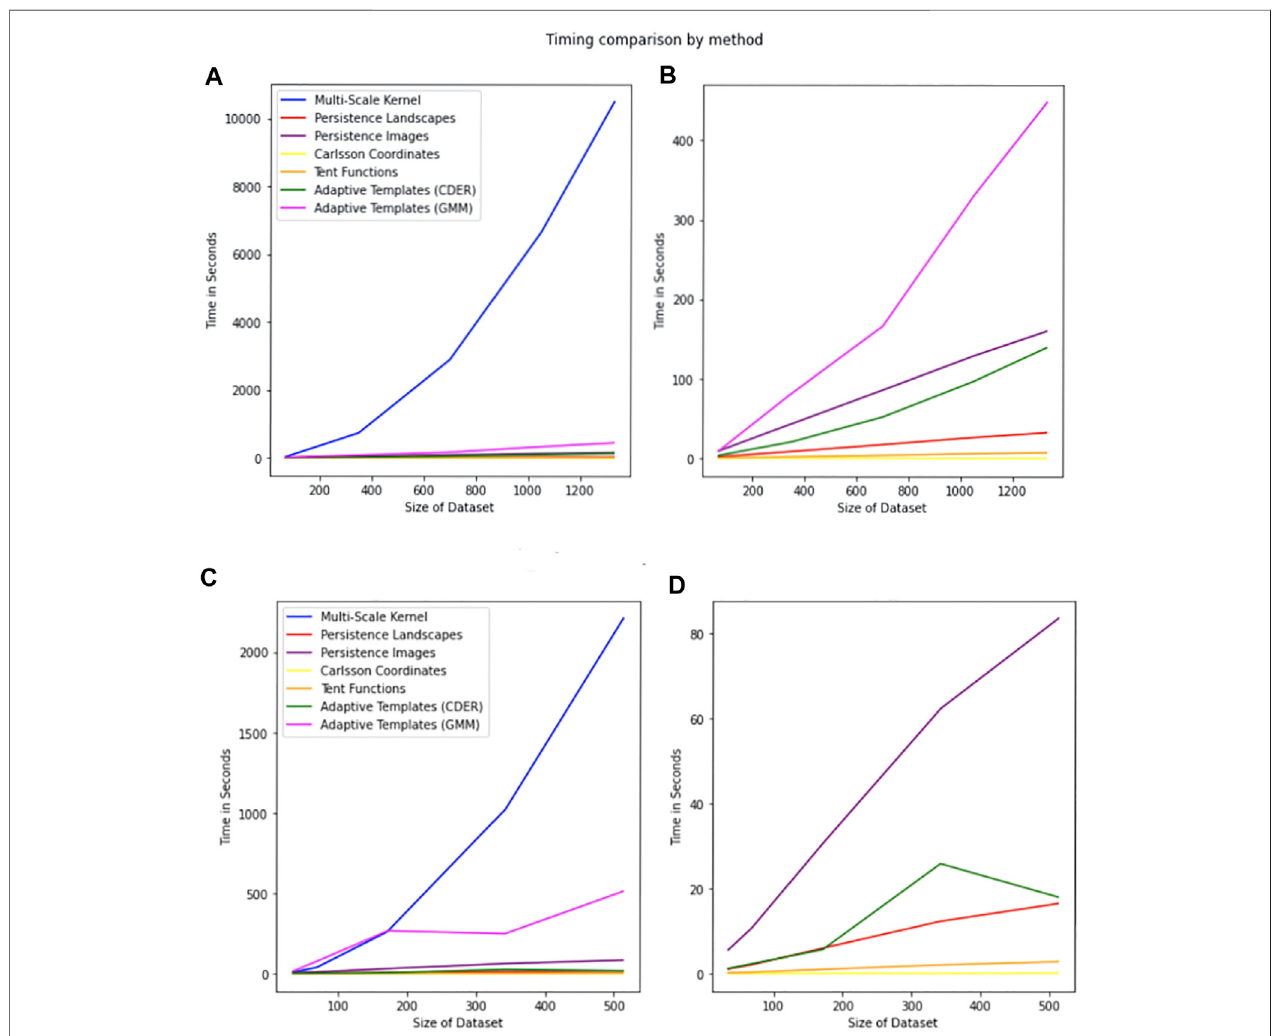
FIGURE10| Comparisonoftimingbymethod. Thelegendisthesameforallplots.Thex-axisrepresentsthesizeofthedataset,andthey-axisrepresents thetime insecondsrequiredforcalculationofallofthepersistence diagramsassociatedwiththedatasetofthegivensize. (A) TimingsfortheMPEG7DatasetincludingtheMulti- Scale Kernel. (B) Timings for the MPEG7 Dataset excluding the Multi-Scale Kernel. (C) Timings for the Protein Dataset including all features. (D) Timings for the Protein Dataset excluding Multi-Scale Kernel and Adaptive Templates